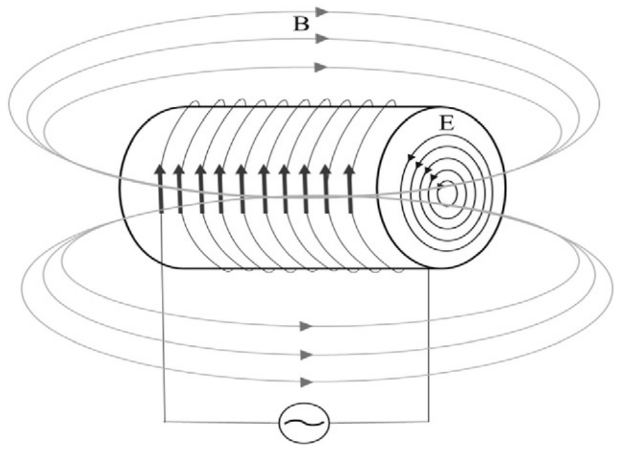
Figure 10. Electromagnetic field generator system